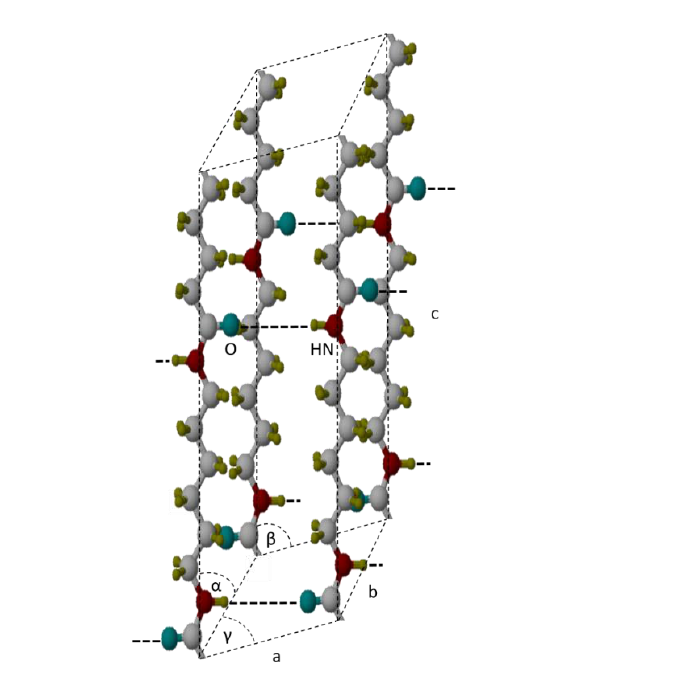
Figure 5. Chain orientation along a-, b-, and c-axes within a triclinic crystalline unit cell of polyamide 66 (PA 66). (white ... carbonate, blue ... oxygen, red ... nitrogen, yellow ... hydrogen).